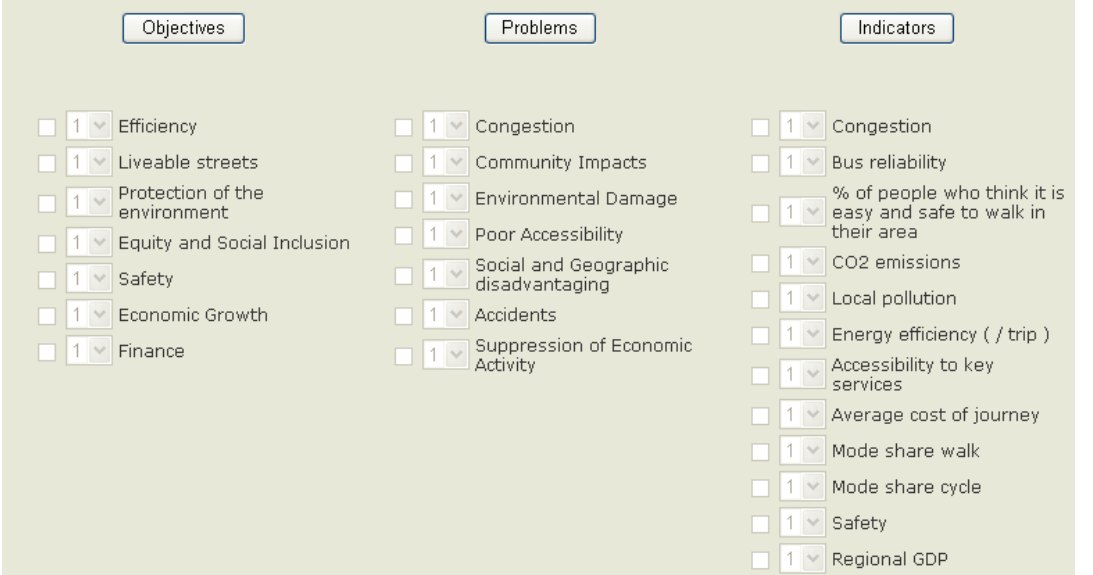
Figure 4. User selection of objectives, problems or indicators Source: Kelly et al (2008a), Figure